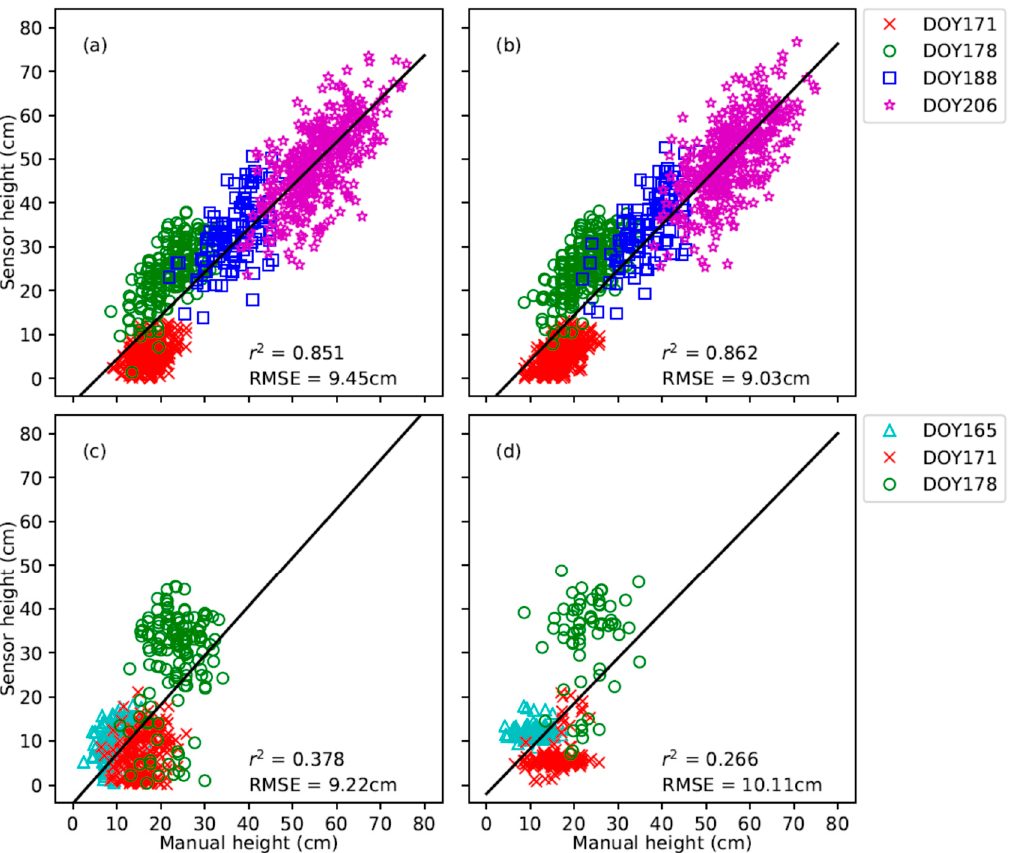
Figure 5. Manual plant height measurements (cm) compared to the Honeywell (HW) ( a ); Pepperl+Fuchs (PF) ( b ); MaxSonars (MS) ( c ); and db3 Pulsar (db3P) ( d ) height measurements within the 360 mid-plots grown at that Maricopa Agricultural Center in Maricopa, AZ in 2016 on the corresponding day of year (DOY).